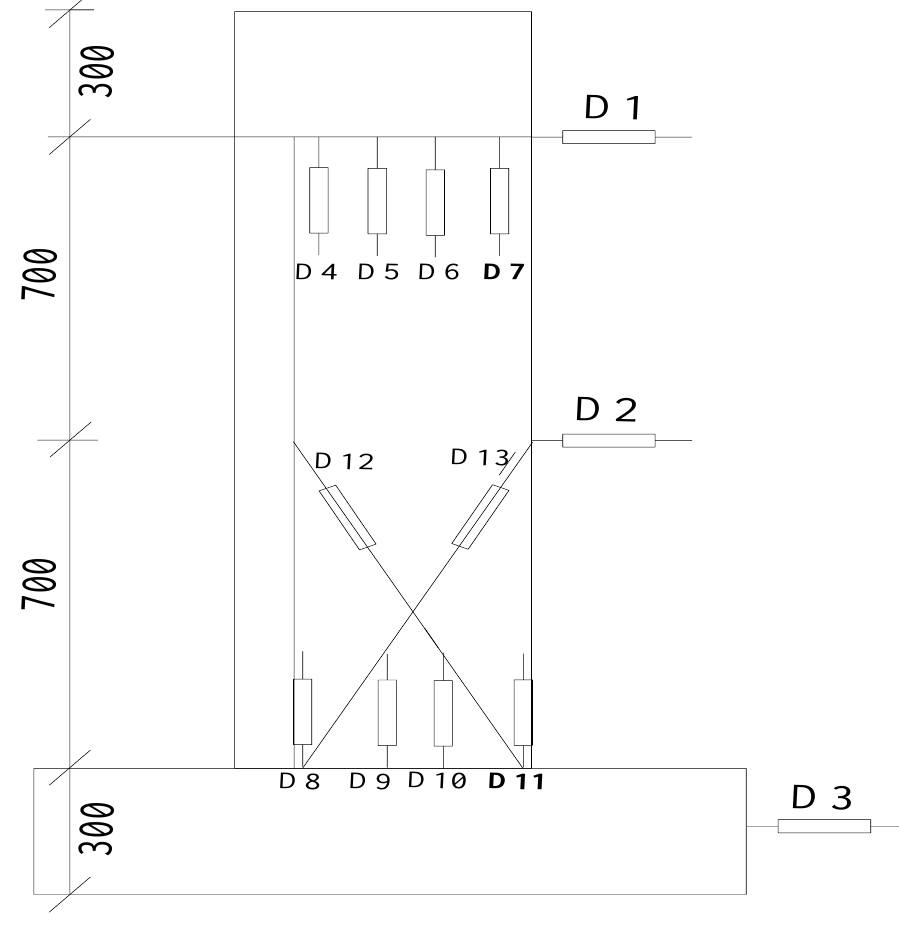
Figure 5. Arrangement of LVDTs in the web wall.